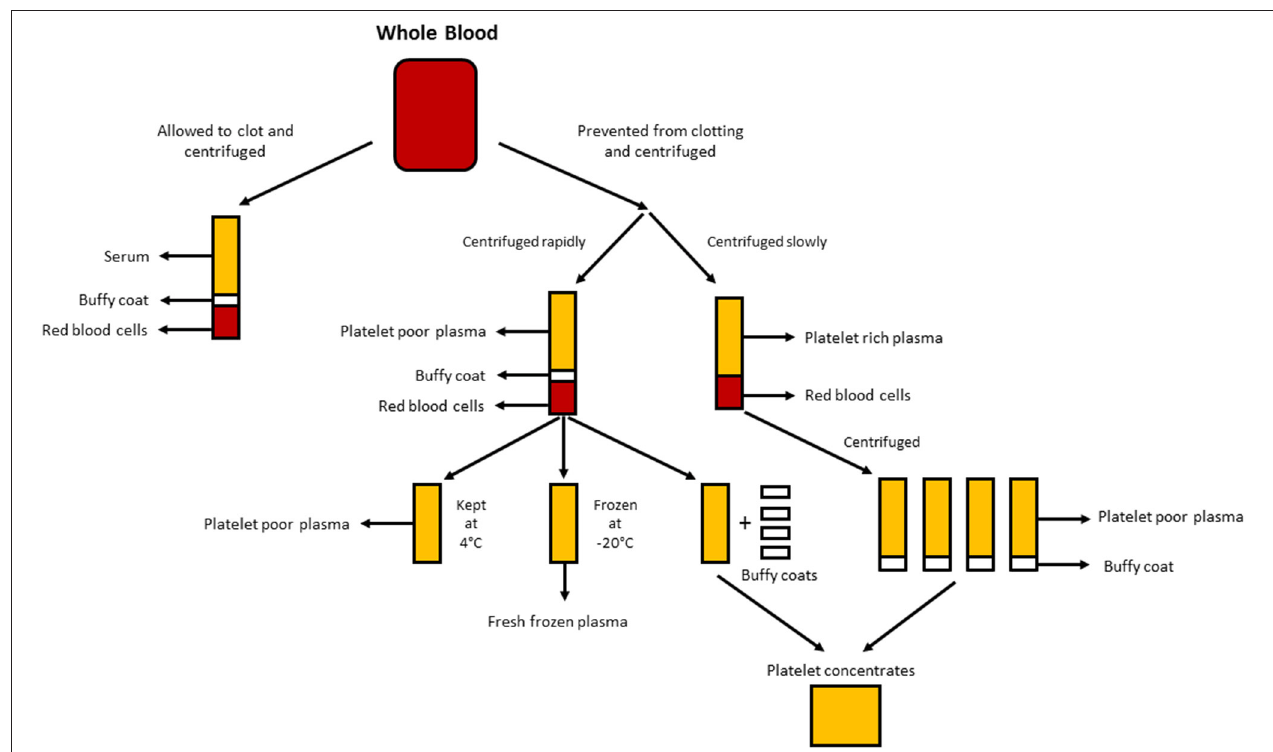
FIGURE 1 | Production of the different human alternatives. Serum is produced when whole blood is allowed to clot and centrifuged to pellet red and white blood cells, and platelets. Plasma is produced by the prevention of clotting followed by centrifugation. Depending on the centrifugation speed, either platelet poor plasma (PPP; rapid centrifugation) or platelet rich plasma (PRP; slower centrifugation) is produced. If the PPP is stored at − 18 ◦ C it is known as fresh frozen plasma. Platelet concentrates can be produced either by taking the platelet poor plasma and 4 buffy coats and pooling them together or centrifuging multiple PRP’s and pooling the platelet pellets (suspended in a small amount of plasma)